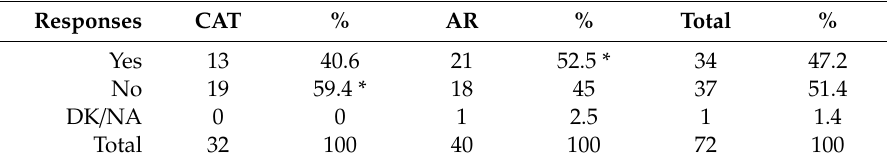
Table 5. Answers obtained in Q3 (source: authors).